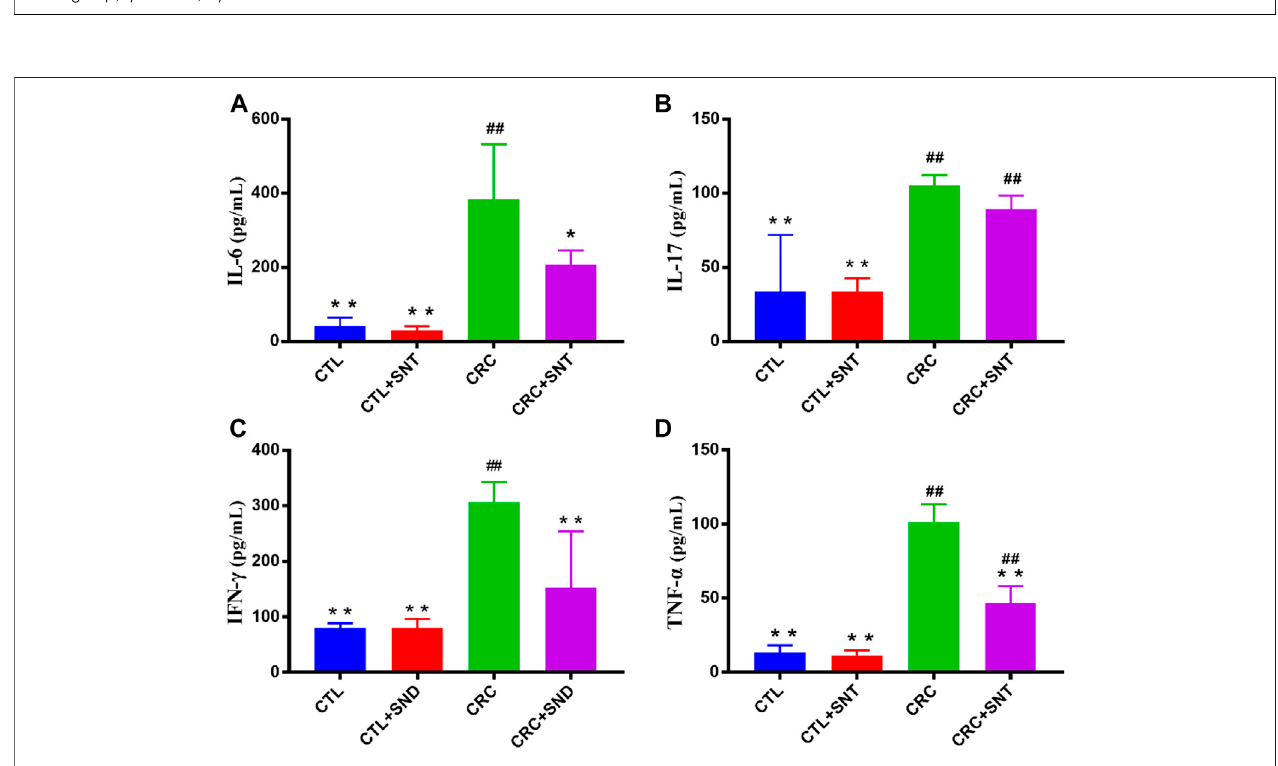
FIGURE5| Changesofproinflammatorycytokinesinmousecolon. (A) IL-6expressionindifferentgroups, n (cid:2) 3. (B) IL-17expressionindifferentgroups, n (cid:2) 3. (C) IFN- γ expression in different groups, n (cid:2) 3. (D) TNF- α expression in different groups, n (cid:2) 3. Compared to CRC group, * p < 0.05, ** p < 0.01; compared to CTL group, ## p <